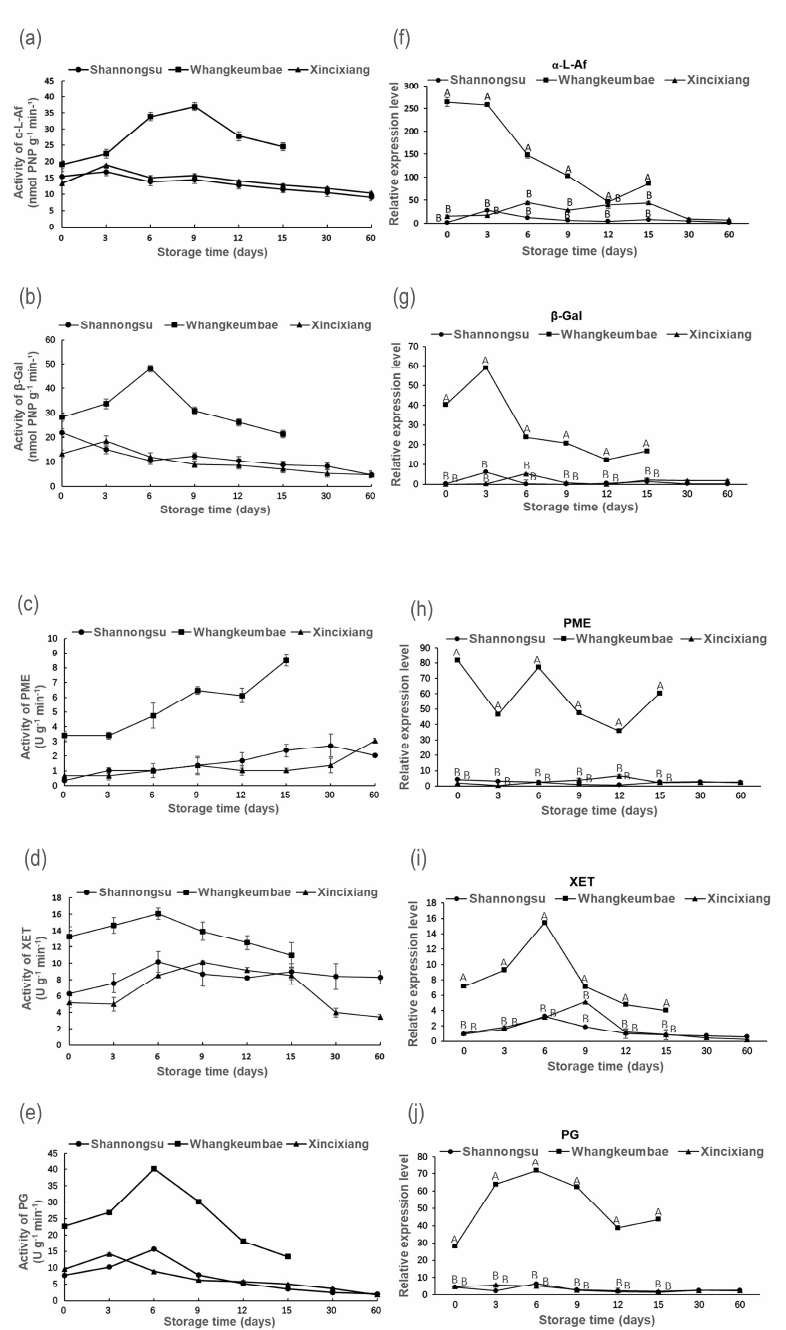
Figure 3. Fruit softening-related enzyme activity and gene expression in three pear cultivars. ( a ) α − L − Af activity, equivalence in p-nitrophenol; ( b ) β − Gal activity, equivalence in p-nitrophenol; ( c ) PME activity, equivalence in d-galacturonic acid; ( d ) XET activity; ( e ) PG activity, equivalence in d-galacturonic acid; and ( f – j ) Gene relative expression levels of α − L − Af, β − Gal, PME, XET and PG at room temperature. Values shown represent means ± SD (n = 3). Different letters indicate significant differences between treatments ( p ≤ 0.01).